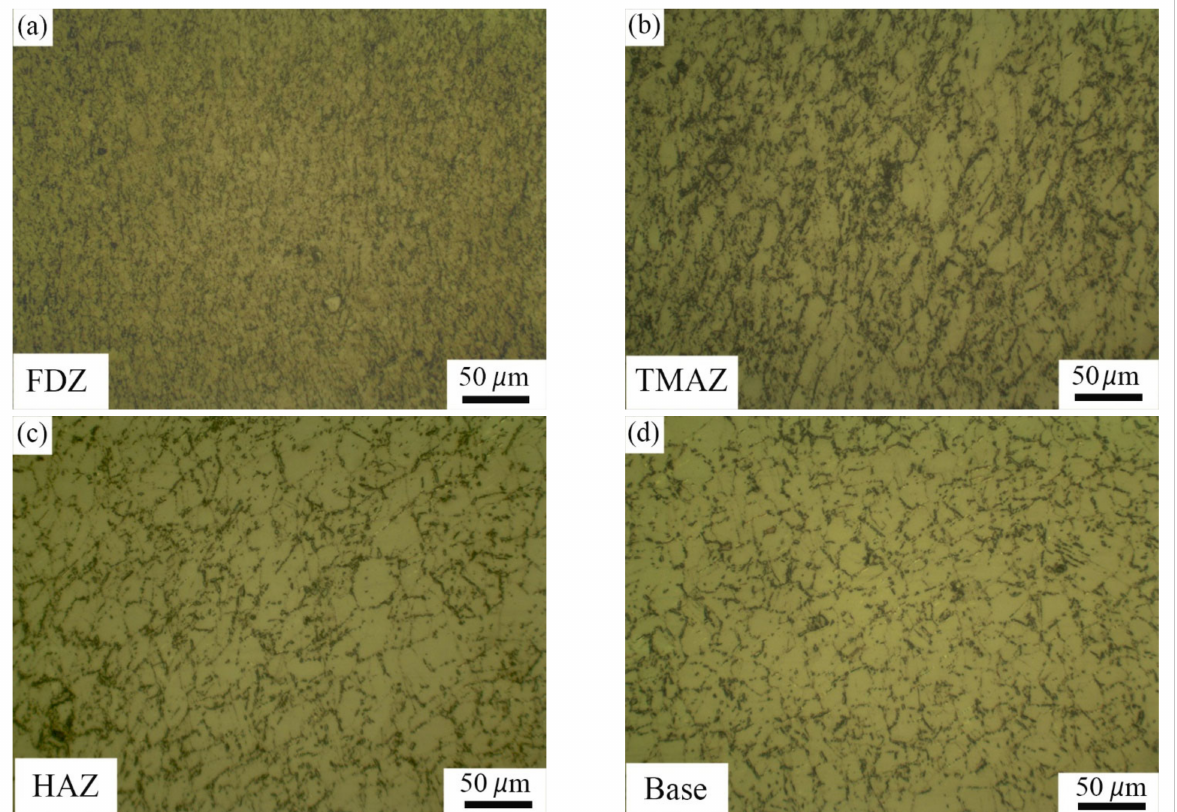
Figure 13. Cross-sectional optical micrographs of dissimilar SS304L/IN718 friction welds in the PWHT condition: ( a ) FDZ, ( b ) TMAZ, ( c ) HAZ, and ( d ) BM